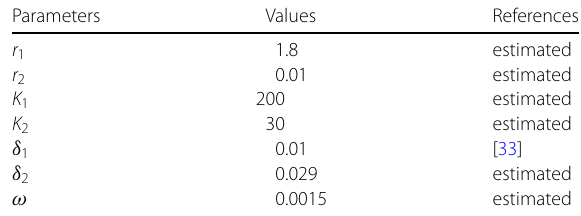
Table 2 Parameter values used for the numerical simulation Parameters